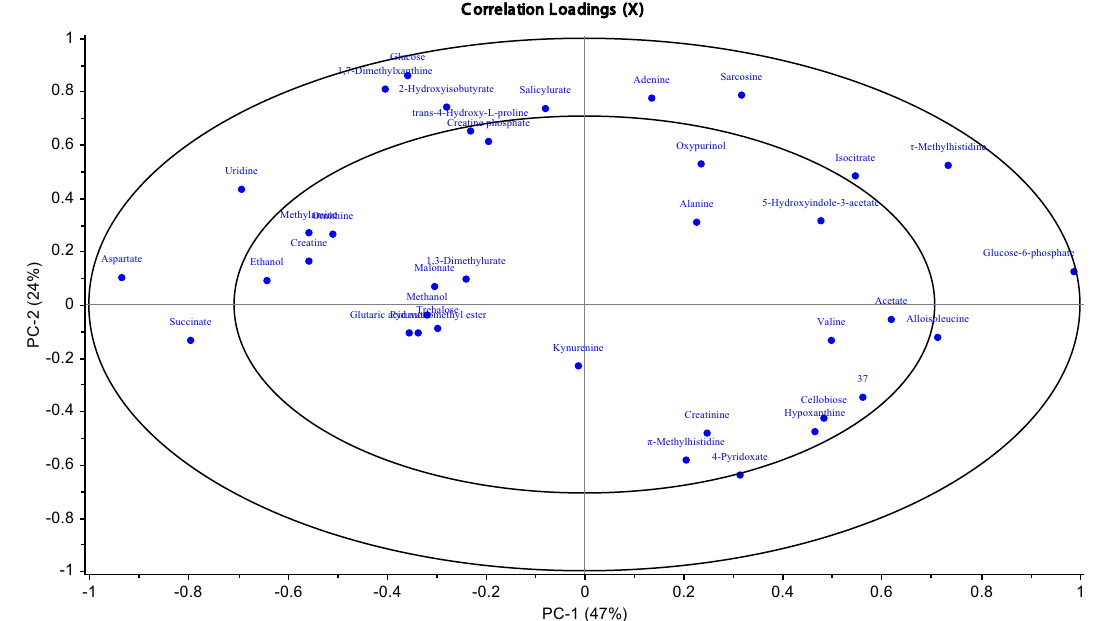
Figure 5. PCA Loadings plot for Mycoplasma pneumoniae from 1D 1 H NMR analysis of serum. REMSEC value for y variable =